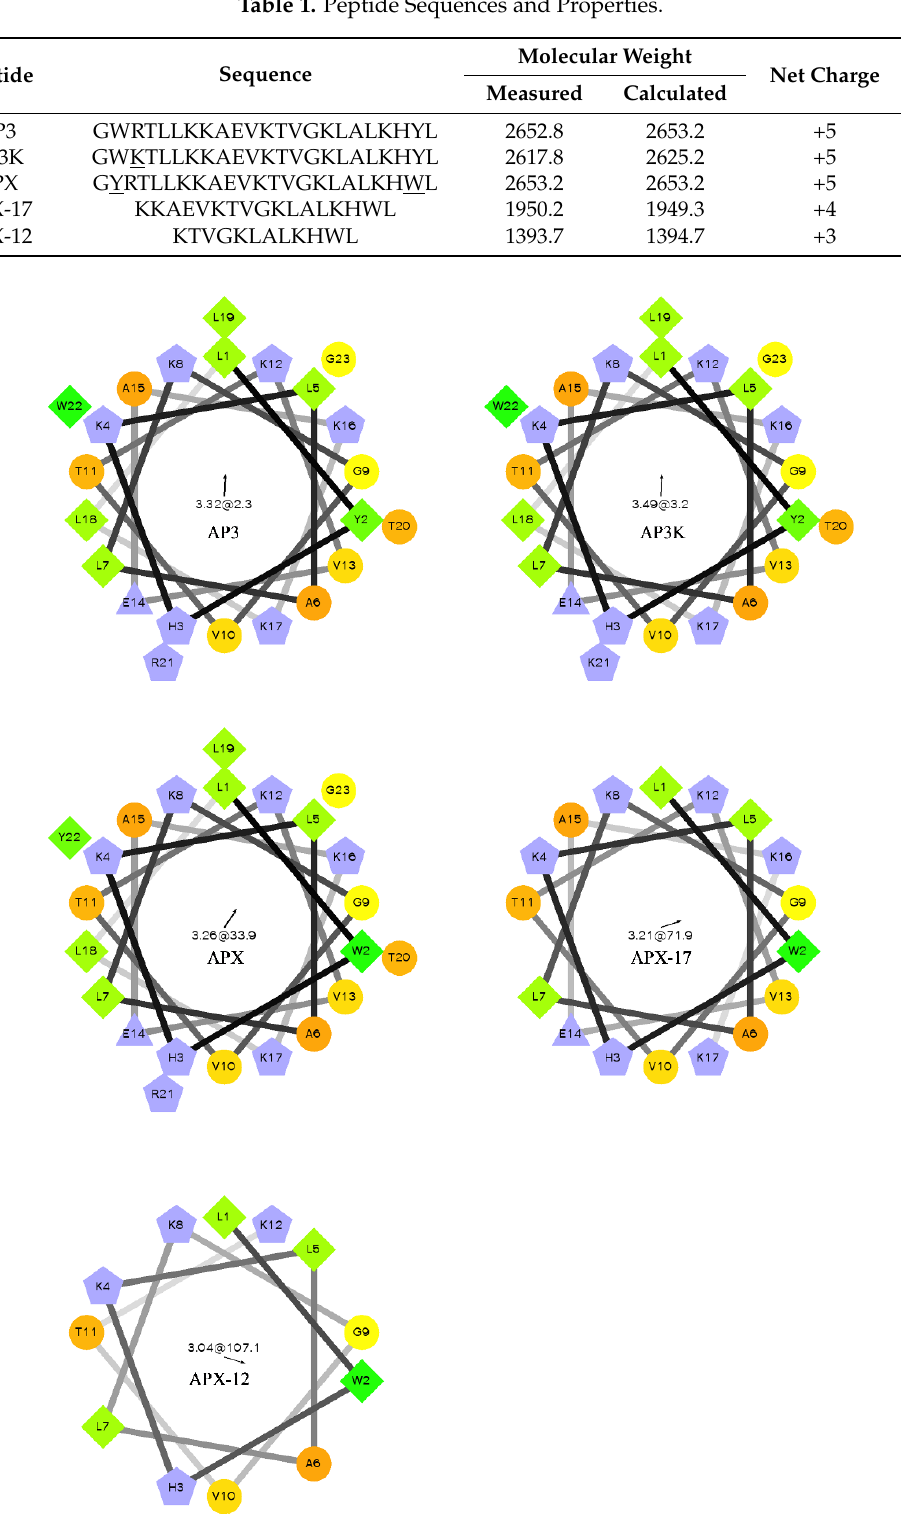
Figure 1. Helical wheel of AP3 and derivative sequences. Orange circles represent hydrophilic residues, green diamonds represent hydrophobic residues, blue triangles represent anionic, and blue pentagons represent cationic residues. The arrow and number at the center of the helical wheel is the direction and magnitude of the hydrophobic moment. Projections were made using http: